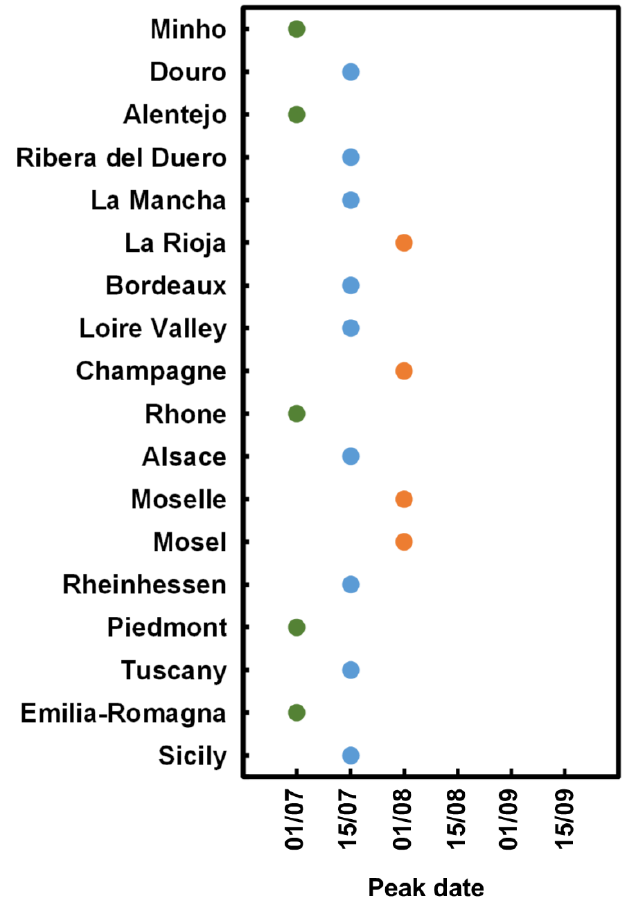
Figure 4. Comparison of the heatwave peak dates over the 18 selected winemaking regions in Europe. Different peak dates are represented by different colors.